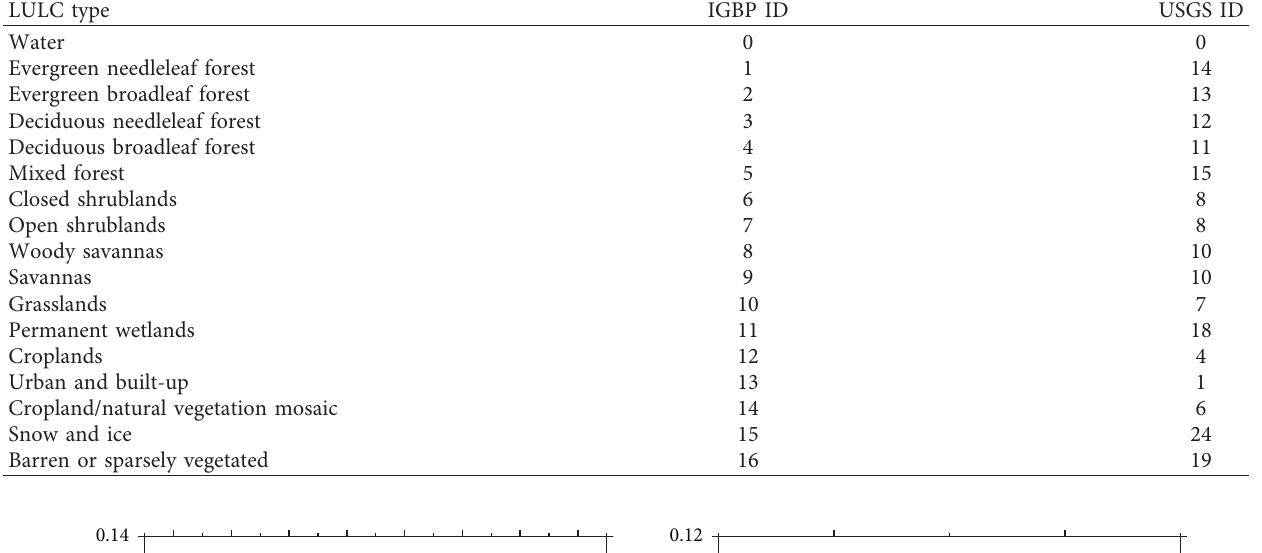
Table 1: Land use and land cover (LULC) mapping between the IGBP and the USGS classifications.